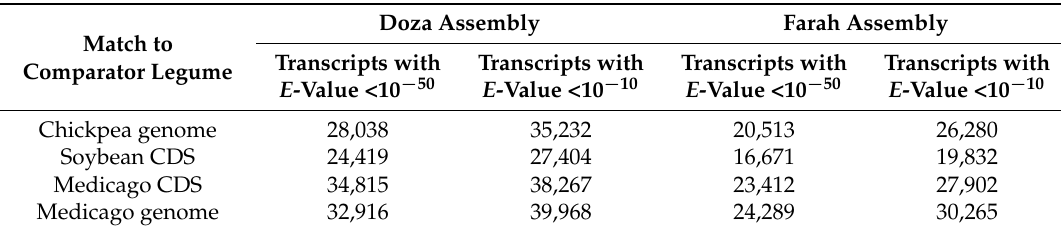
Table 3. E -value distribution of the faba bean transcripts BLAST results to sequences from other closely-related species.